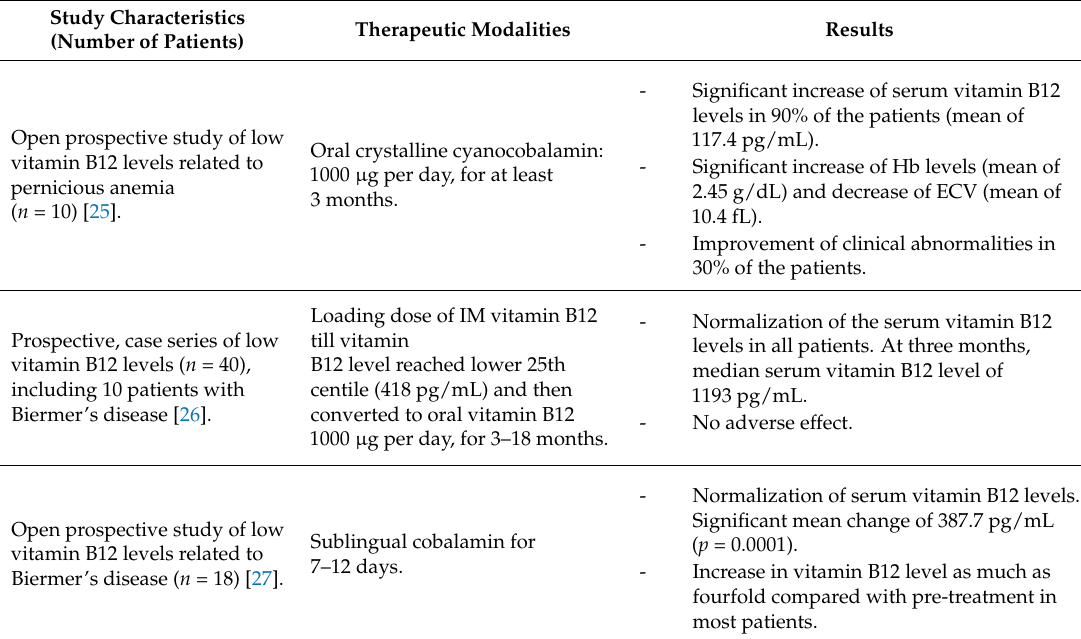
Table 3. Studies of oral vitamin B12 treatment in patients with vitamin B12 deficiency related to Biermer’s disease (pernicious anemia) (number of studies =